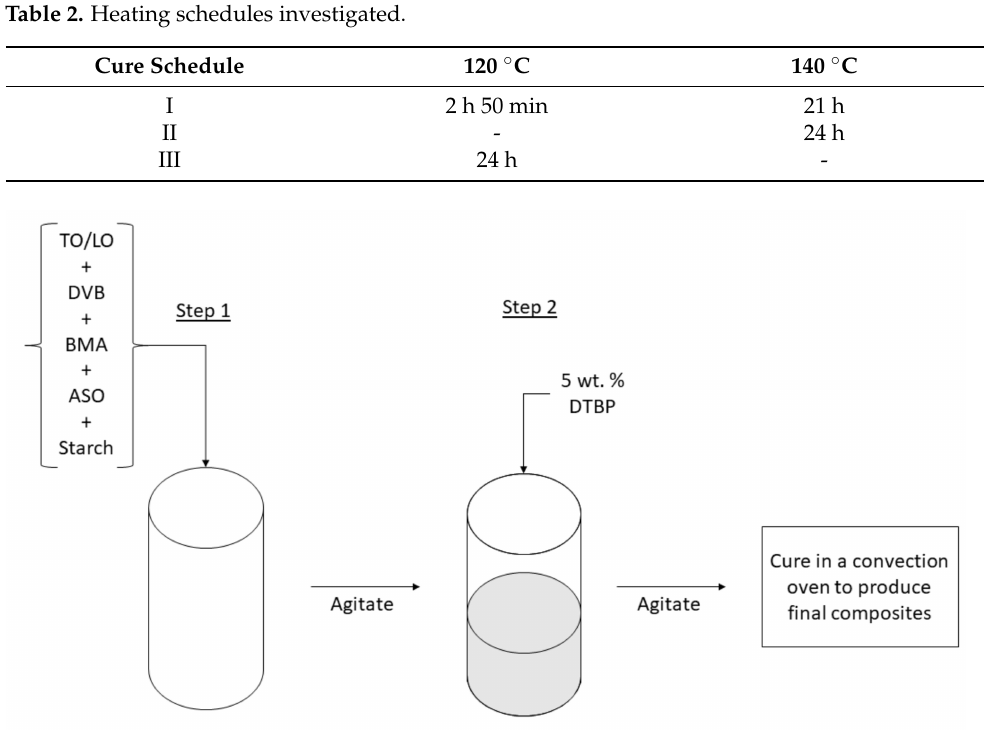
Figure 2. Schematic of composites